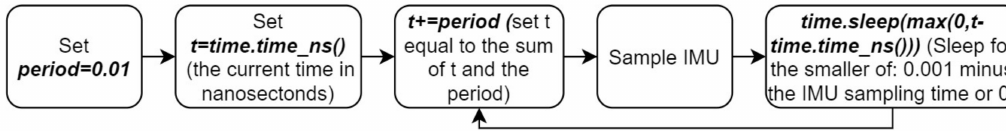
Figure 16. IMU time synchronisation